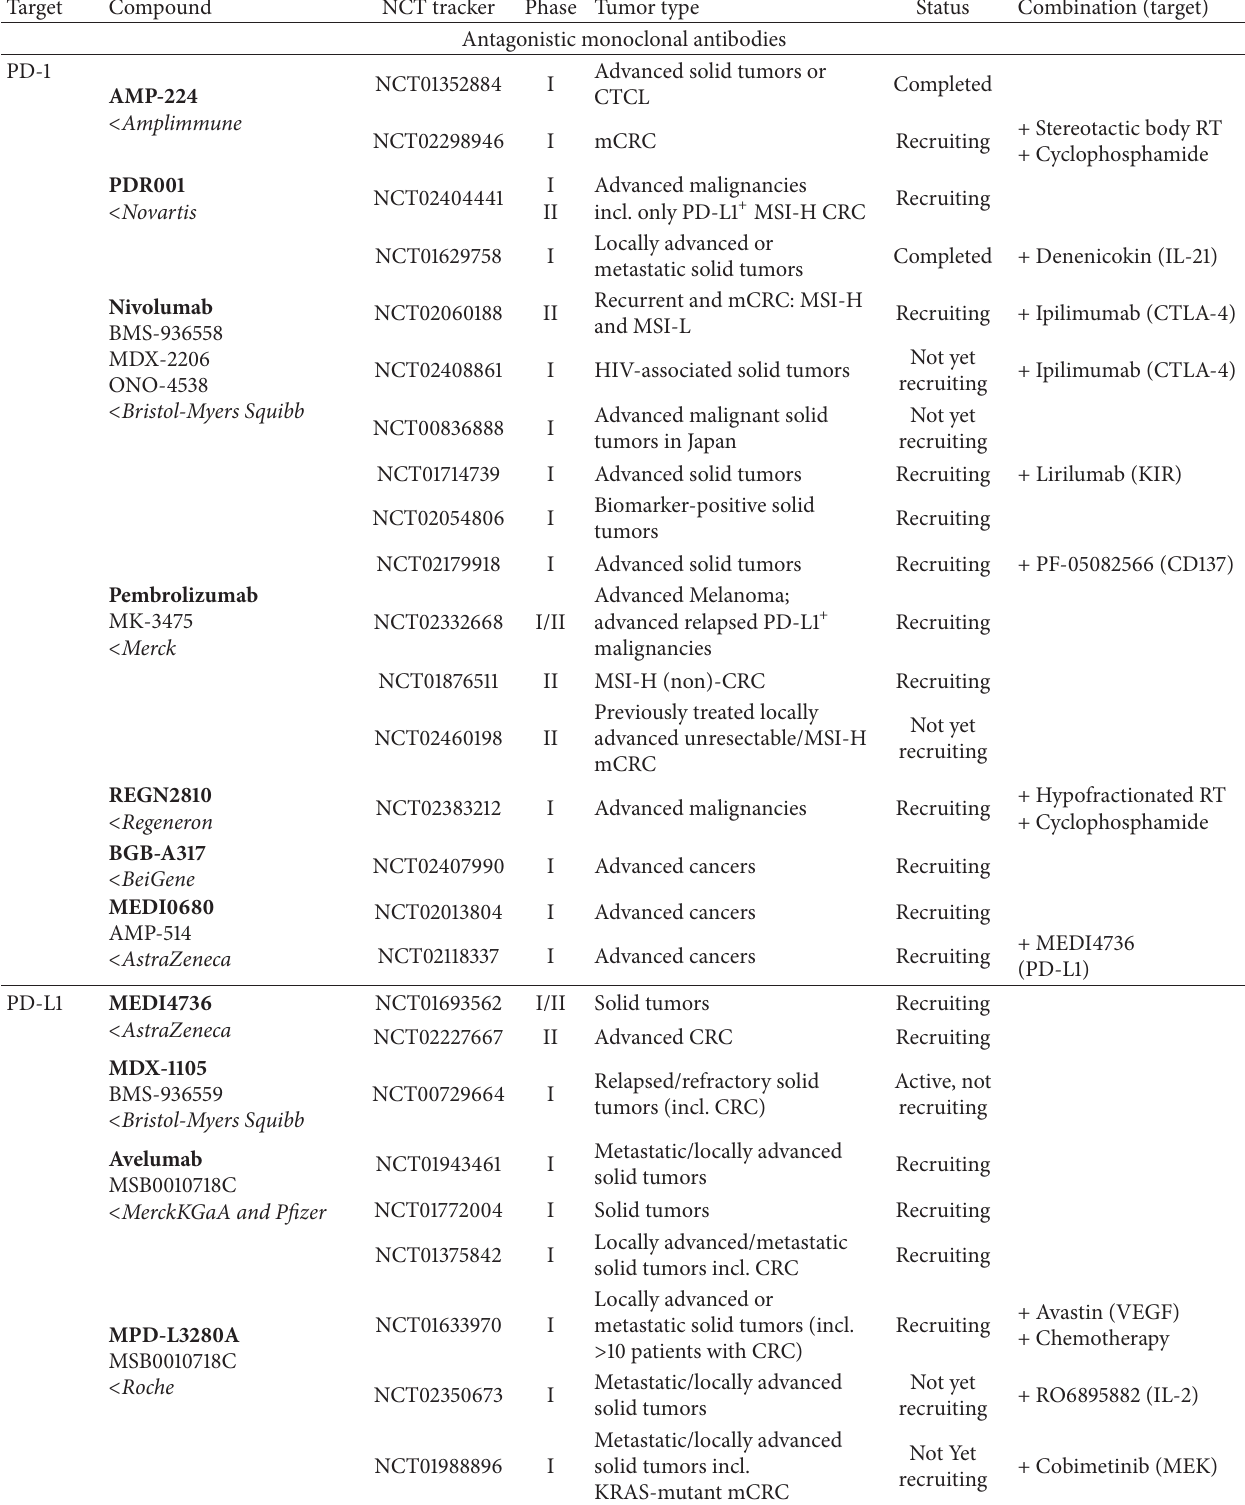
Table 1: Clinical trials testing immune checkpoint modulators in colorectal cancer (according to https://www.clinicaltrial.gov/, 19th of June